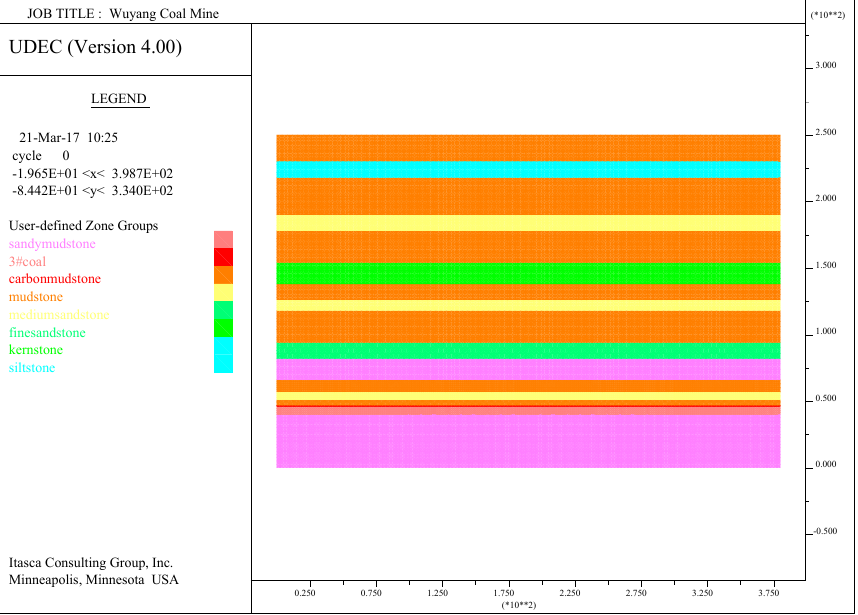
Figure 3. Numerical calculation model.